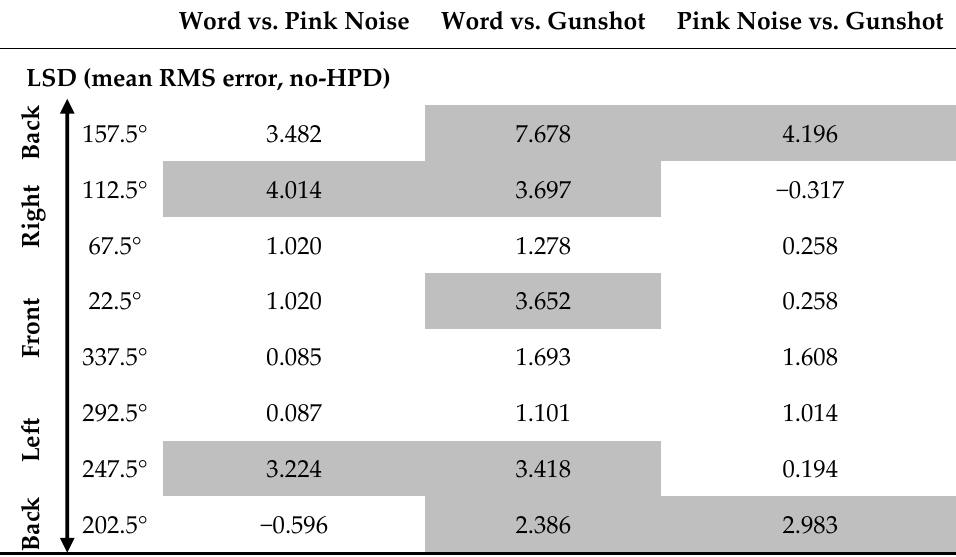
Table 2. Post hoc LSD analyses between stimuli used in the study at each monitor angle. Word vs. Pink Noise Word vs. Gunshot Pink Noise vs.